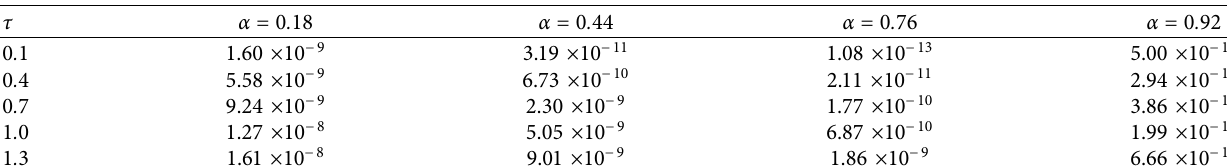
Table 2: He-laplace error in Example 1 at different values of α when ρ � σ � 1, ] � 0 . 8 and x � 20.